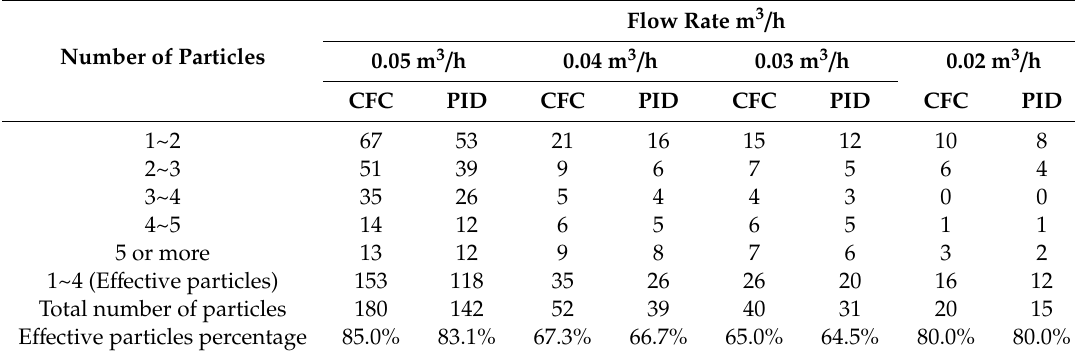
Table 8. Spray conditions at various flow rates at the pressure of app. 0.1